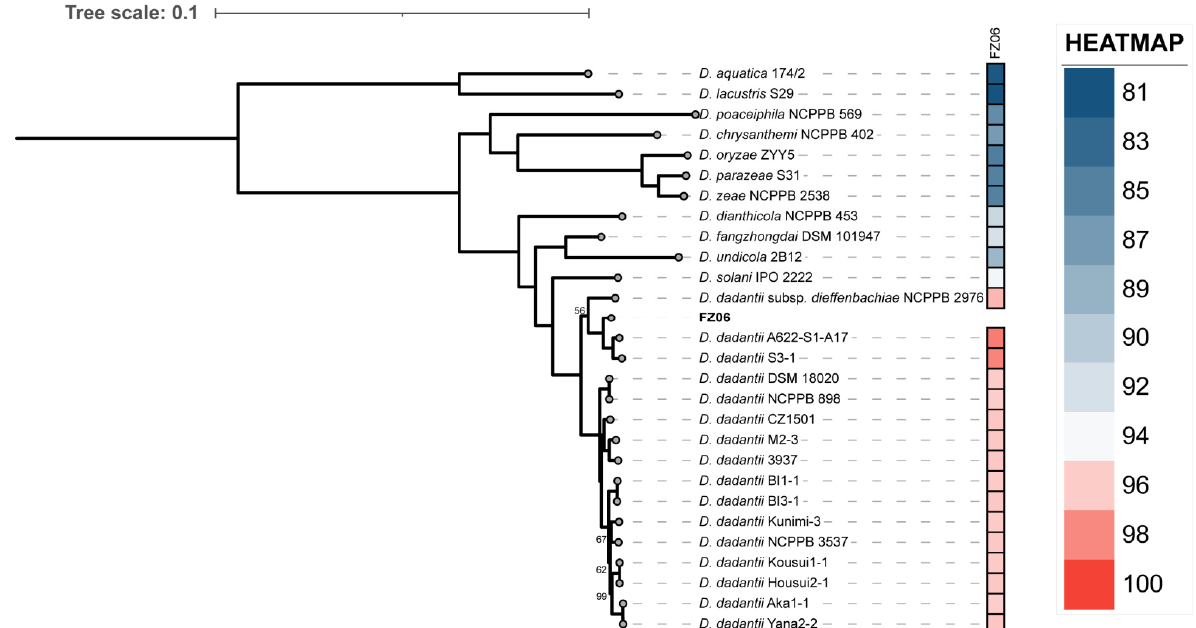
Figure 4. Phylogenetic tree based on 1264 bacterial conserved orthologous single-copy genes of strain FZ06, 16 D. dadantii, and 11 type strains of other Dickeya spp. Single-ANI analysis was used by means of fastANI v1.3 [44]. The closest strain of FZ06 is D. dadantii A622-S1-A17, with a 98.4955% ANI value.